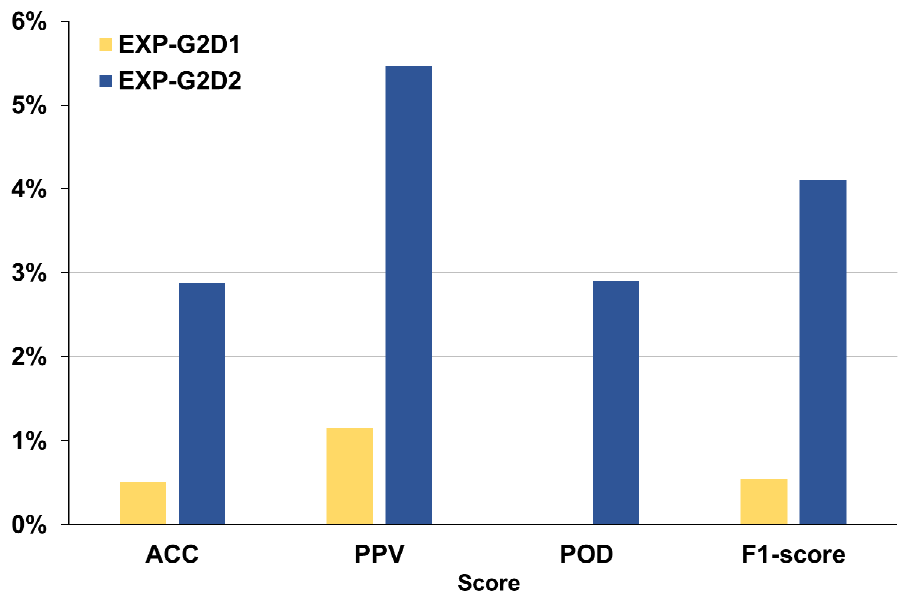
Figure 7. The difference ratio of ACC, PPV, POD, and F1-score for EXP-G2D1 (yellow) and EXP-G2D2 (blue) relative to EXP-G1D1.